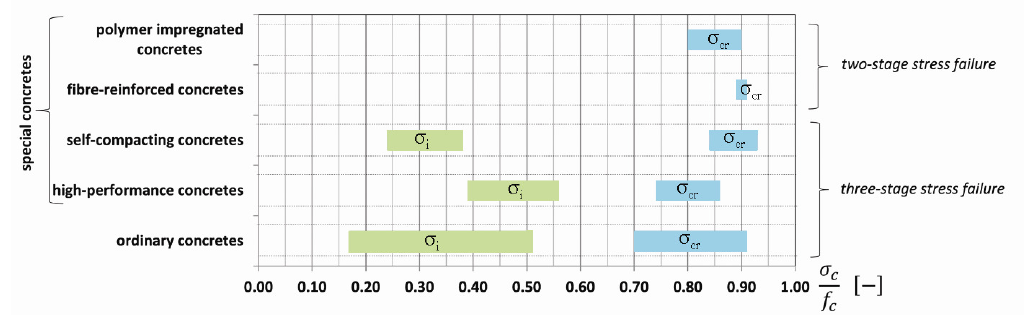
Fig. 11. Cracking initiating stress σ i and critical stress σ cr intervals in ordinary concretes, high-performance concretes and special concretes